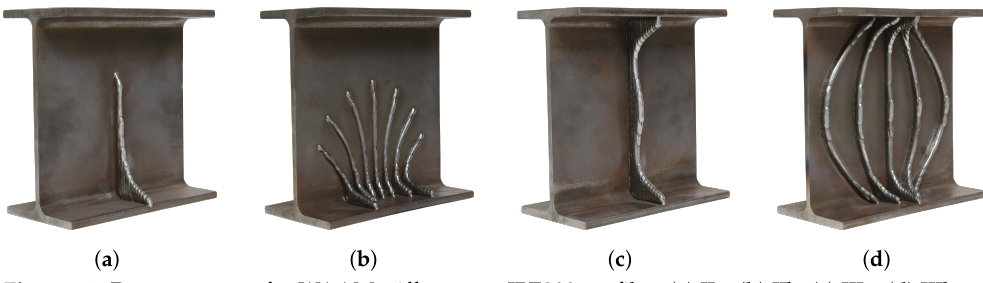
Figure 24. Demonstrators for WAAM stiffeners on IPE200 profiles: ( a ) IIa; ( b ) IIb; ( c ) IIIa; ( d )